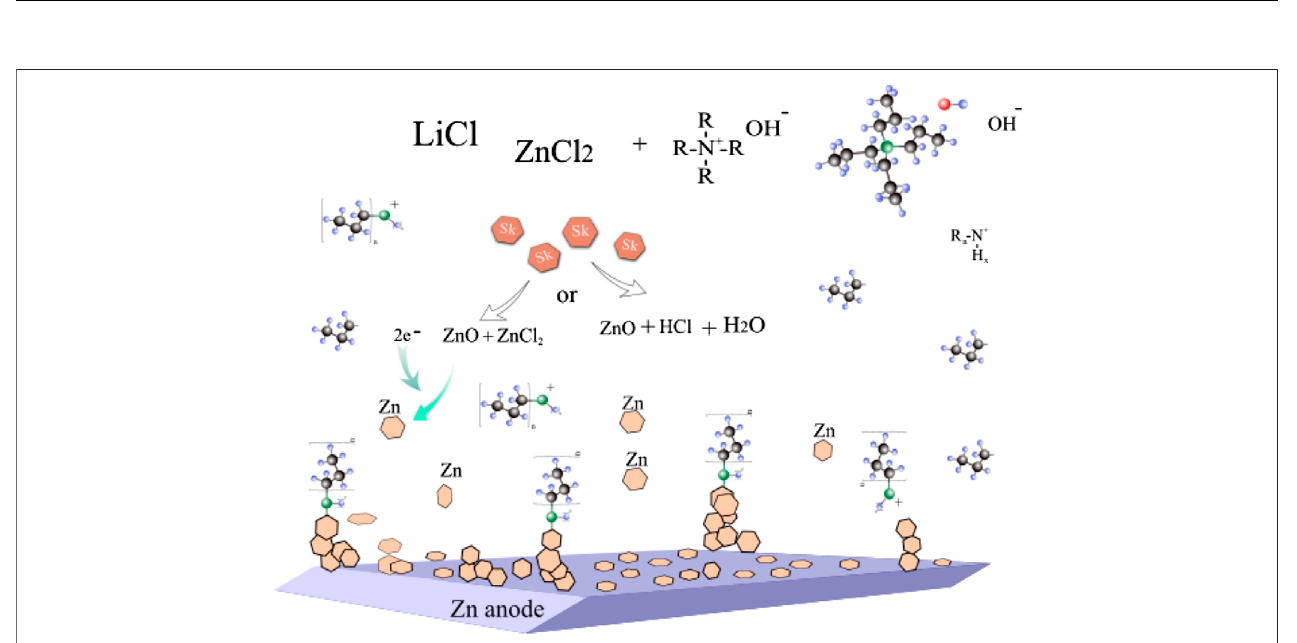
FIGURE 7 | A proposed mechanism of Zn dendrite suppression by TPAH electrolyte additive.